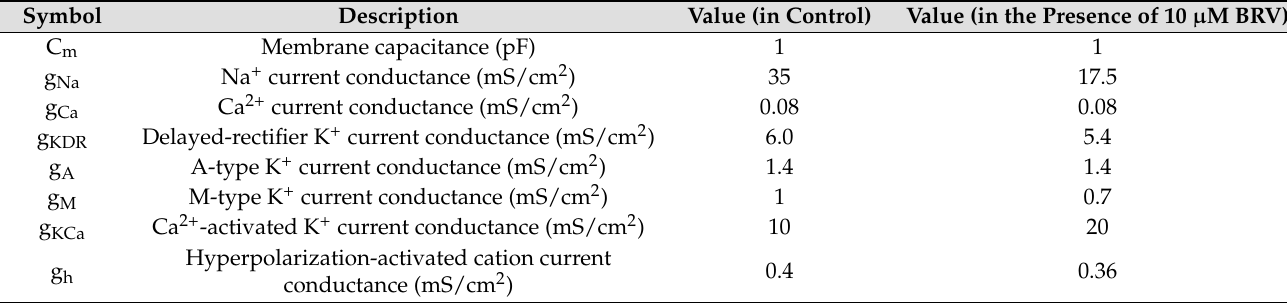
Table 1. Parametric values used for the modeling of hippocampal CA1 pyramidal neurons in an attempt to mimic the experimental results obtained in the control, where brivaracetam (BRV) was not present and during exposure to 10 µ M BRV. Symbol Description Value (in Control) Value (in the Presence of 10 µ M BRV) C m Membrane capacitance